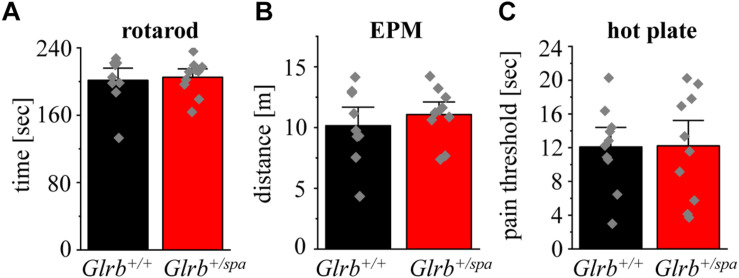
Motor behavior and pain sensation are unaffected in heterozygous spastic animals. (A) Rotarod performance of Glrb+/spa mice (n = 10, red bar) and Glrb+/+ mice (n = 9, black bar) with accelerating speed. Time until mice fall off the rod is shown as mean. (B) Traveled distance of Glrb+/spa mice (n = 10, red bar) and Glrb+/+ mice (n = 9, black bar) within open and closed arms in the elevated plus maze (EPM) test is depicted. (C)
Glrb+/spa mice (n = 10, red bar) and Glrb+/+ mice (n = 10, black bar) were placed on a hot plate. Threshold until mice licking their hind paws was detected. Error bars refer to S.E.M. values. Data points are shown as gray color squares.